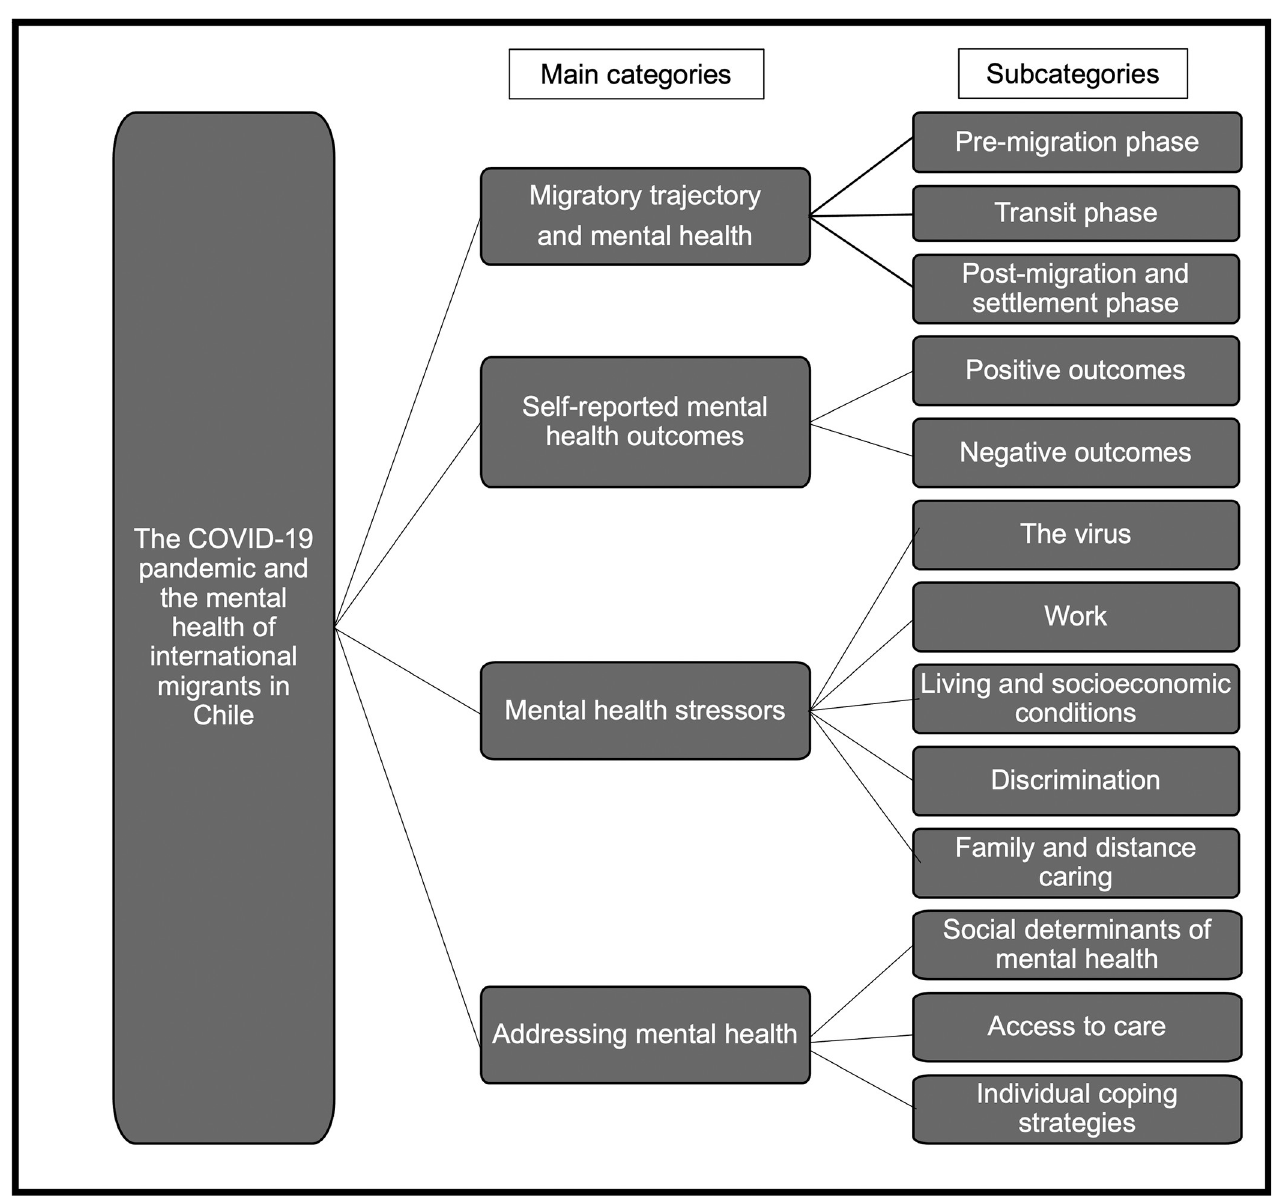
Fig 1. Coding tree.